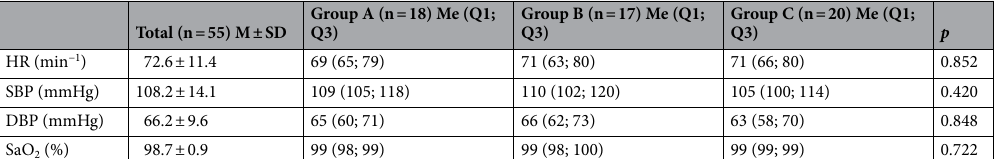
Table 2. Hemodynamic status of the patients during the surgery. HR heart rate, SBP systolic blood pressure, DBP diastolic blood pressure, SaO 2 arterial blood saturation, M mean, SD standard deviation, Me median, Q1 quartile 1st, Q3 quartile 3rd, n number of participants, p level of statistical